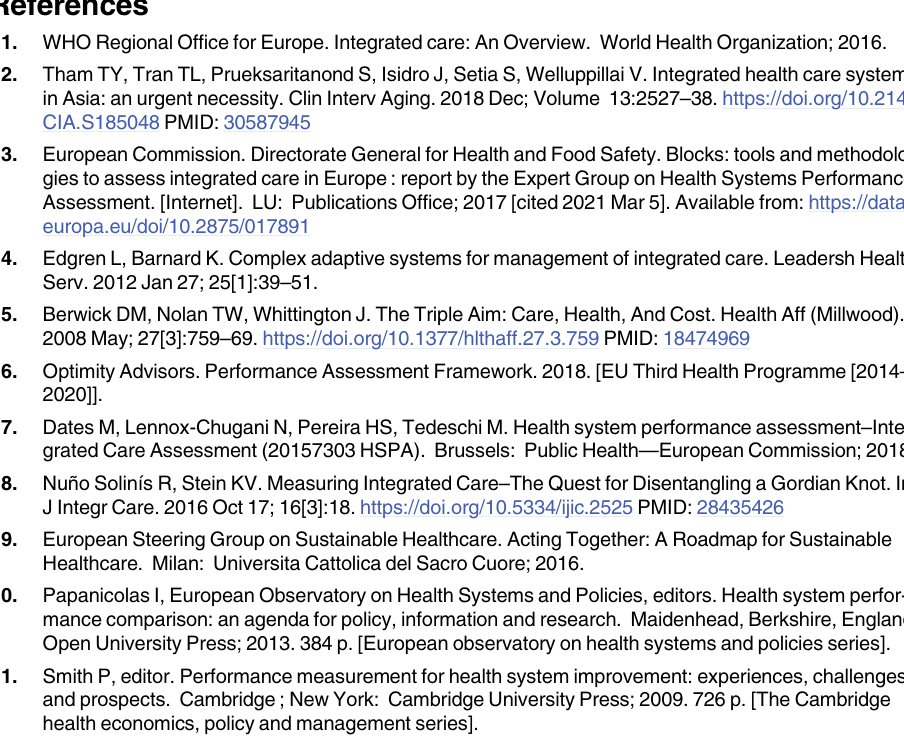
S3 Table. Data extraction